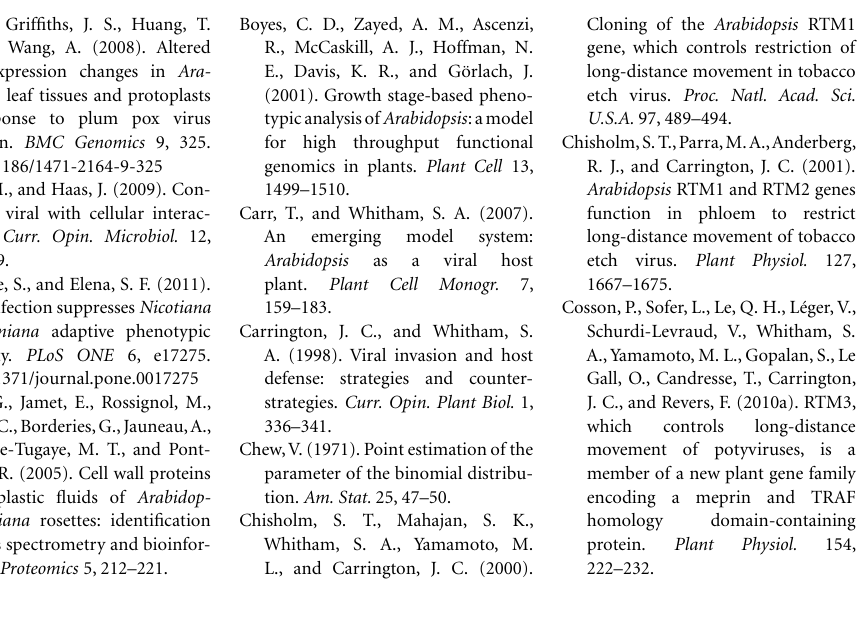
Figure S1 | Examples of symptoms induced byTEV- At 17b on the different A. thaliana ecotypes used in this study. In all panels, the plant at the left is a healthy, mock-inoculated plant, whereas the plant at the right corresponds to an infected sick plant. For Ei-2 and St-0, two pictures are shown (lateral and zenithal views). Table S1 | Excel file containing the list of all genes whose expression has been significantly altered (up- and down-regulated) upon infection with TEV- At 17b. Table S2 | Excel file containing the lists of genes shared between ecotypes that belong to Groups 1 and